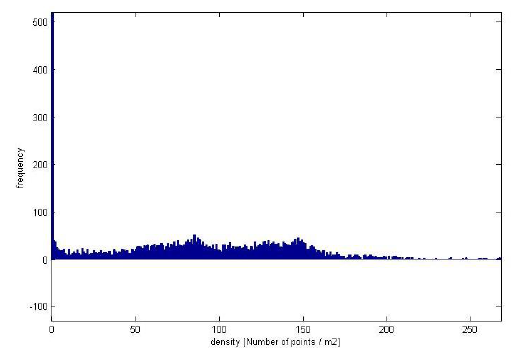
Figure 11. Histogram of density (points/m 2 ) for filtered point cloud